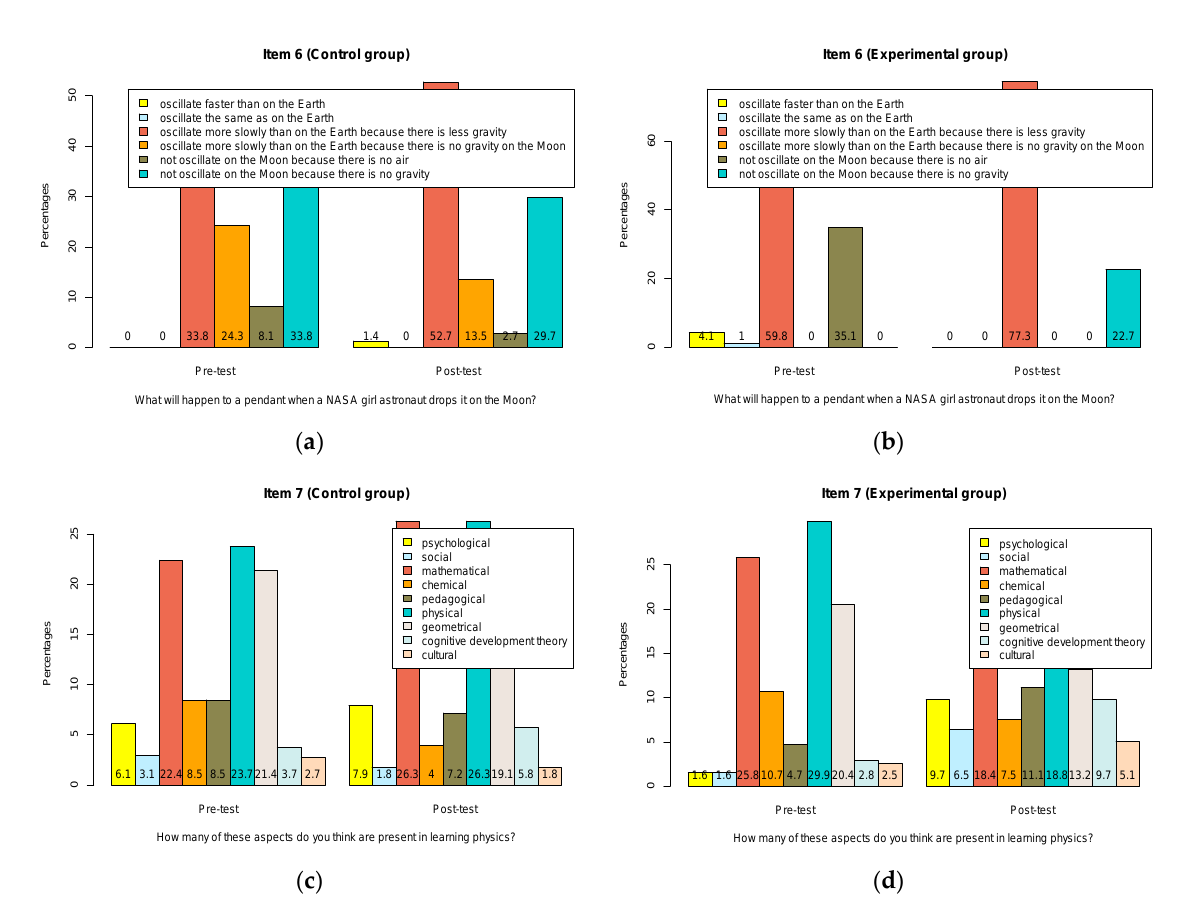
Figure 3. In the item 6, ( a ) the control group maintained statistically the same responses, but in experimental group ( b ), a conceptual change was observed. Gravity was the reason why a pendulum swings. In the item 7, the control group ( c ) nearly noticed differences in the different areas, but in experimental group ( d ), the psychological, pedagogical, social, cognitive development, and cultural aspects (social science group) obtained an increase by using several resources. Table 4. Summary of the inferential data obtained through the pre- and post-tests, as well as the observed changes obtained by the experimental